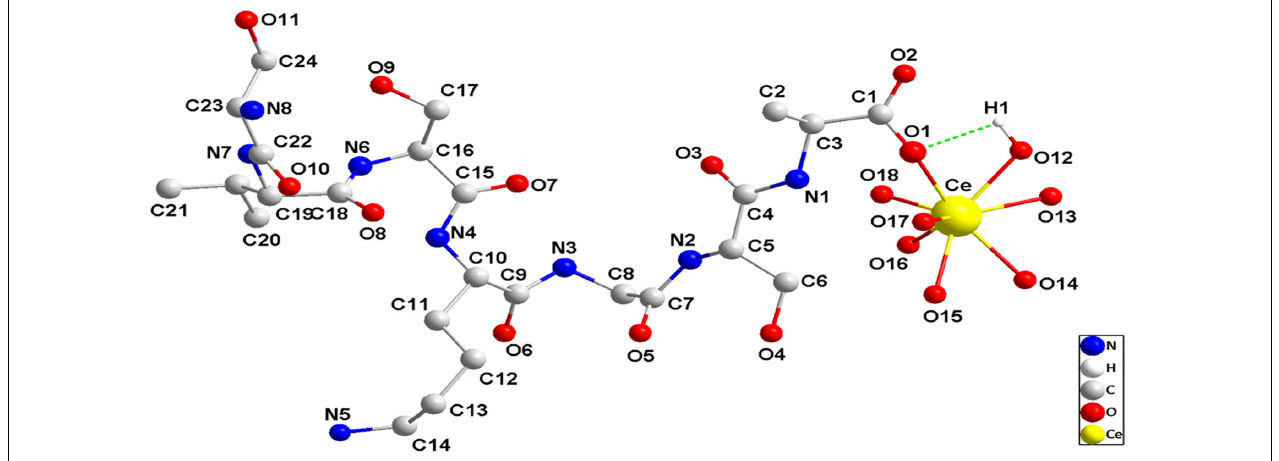
FIGURE 9 | The partial schematic diagram of AtFLA11 coordinately bound to [Ce(H 2 O) 7 ](III) to form [Ce(H 2 O) 7 ](III)-AtFLA11